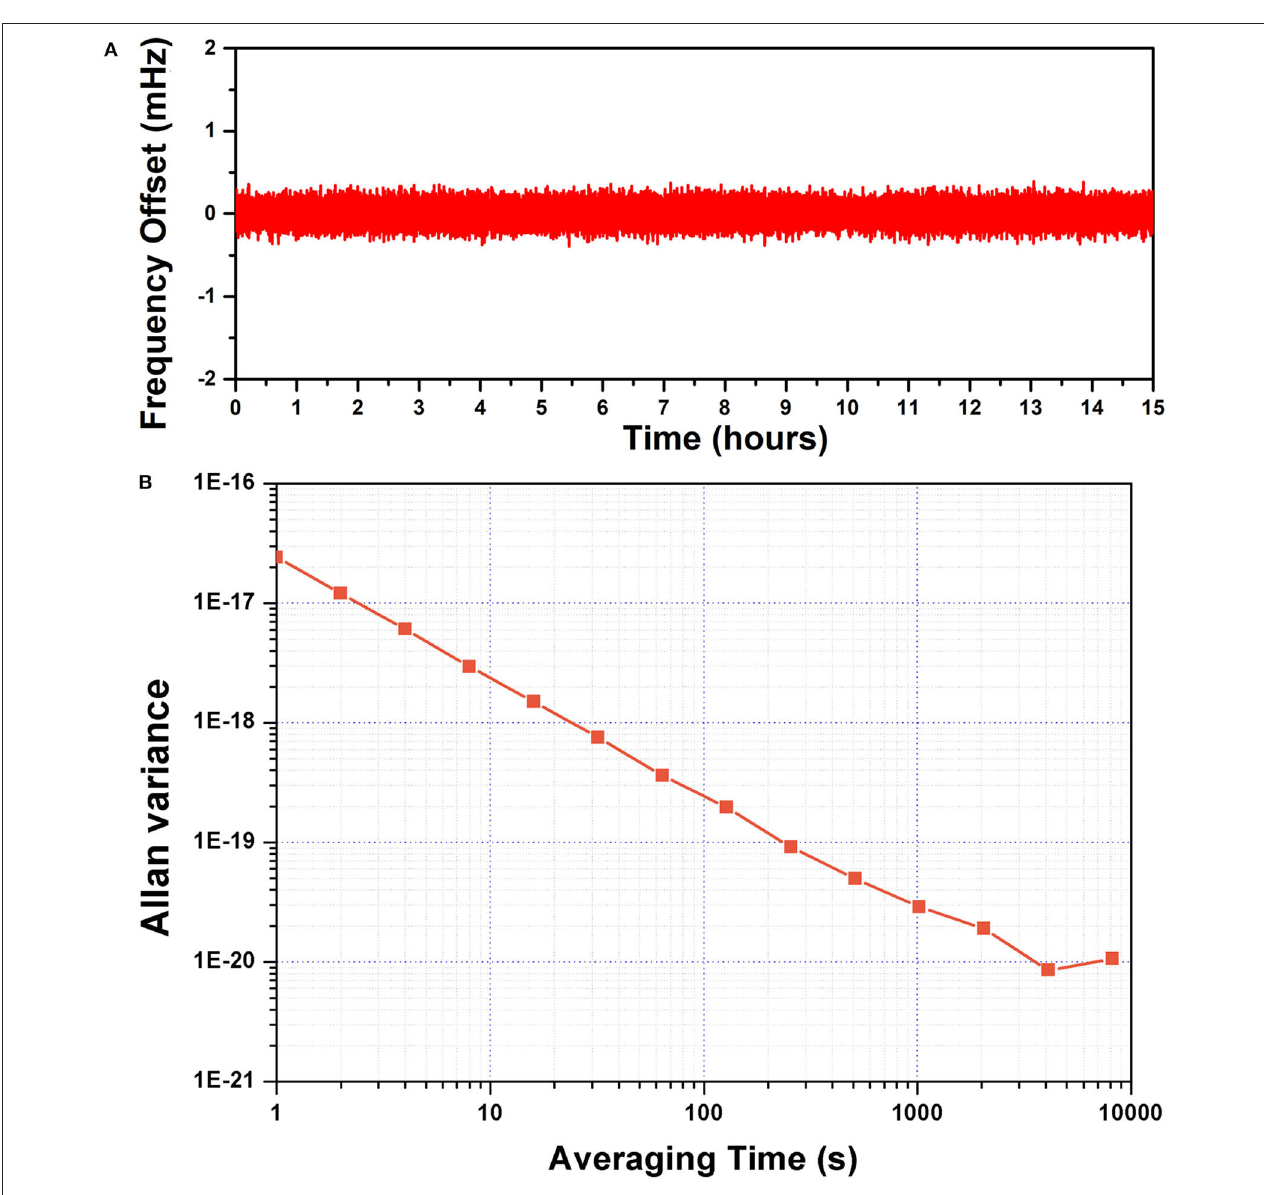
FIGURE 4 | (A) Frequency deviation of f beat for hours; (B) the Allan deviation of f beat for